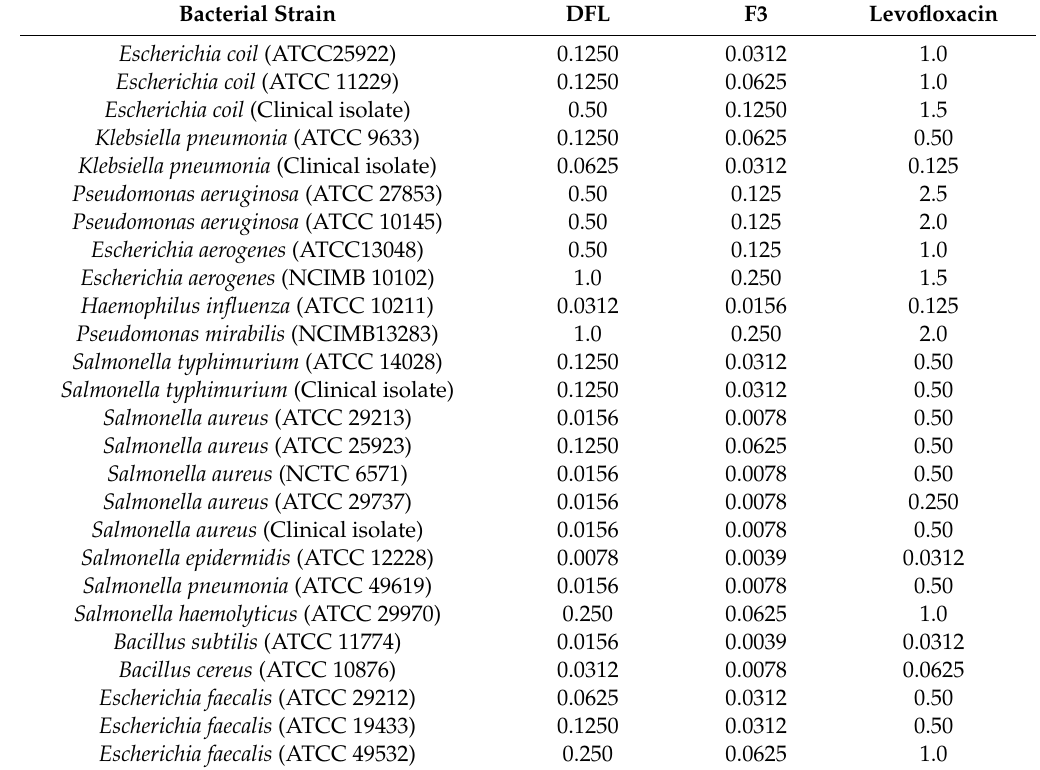
Table 3. Minimum inhibitory concentrations (MICs) ( µ g / mL) of DFL and its DFL-loaded L-P-NPs (F3) against bacterial pathogens compared with